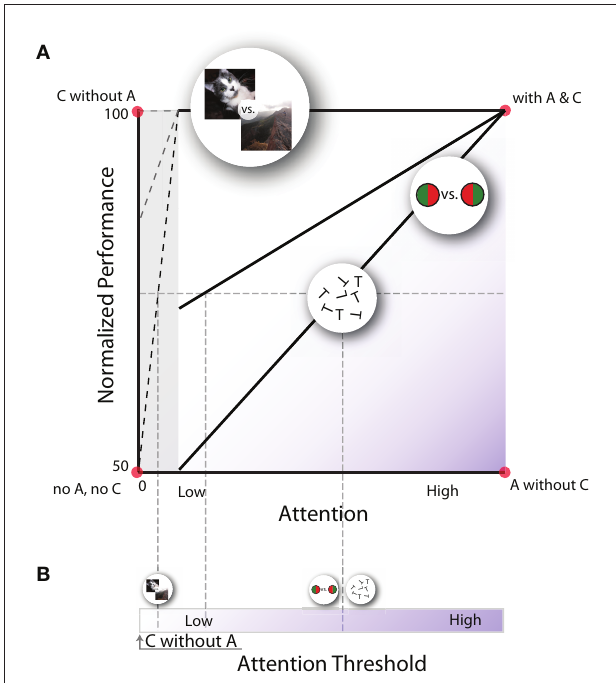
Figure 2 | Schematic framework for the relationship between attention and task performance. (A) Performance-resource functions, which show psychophysical performance for a given amount of allocated attention. Each curve describes this relationship for different types of discrimination tasks; some discrimination tasks require a lot of attentional resources (lower diagonal line), others require little (middle diagonal line) or no (top line) attentional resources. Note that each of the four corners in this plot depicts one of the quadrants in Table 1 (here A = attention, and C = consciousness). (B) Let us assume that when observers can consciously discriminate two stimuli at 75% correct, they are conscious of the difference to a certain degree. If we accept this, we can measure an attention threshold for a given aspect of visual attribute: how much attention is required to achieve a certain level of conscious discrimination. For example, the attentional threshold for natural scene discrimination (top line) is much lower than those for discriminating red/green bisected discs or rotated letters (bottom